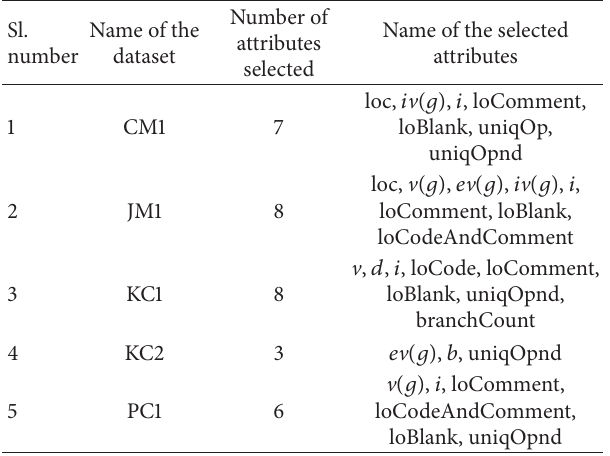
Table 3: Selected attribute metrics to act as input for the proposed predictor model. Sl.